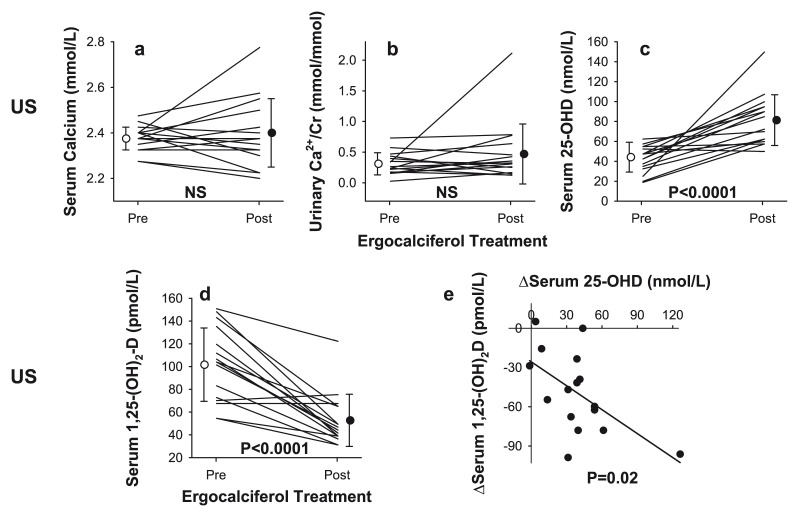
Serum and urine biochemical profiles in patients with sarcoidosis before and after vitamin D supplementation.Changes in (a) serum calcium, (b) urine calcium, (c) serum 25-hydroxyvitamin-D (25-(OH)D), and (d) serum 1,25-dihydroxyvitamin-D (1,25-(OH)2D) and (e) relationship between changes in serum 1,25-(OH)2D and 25-(OH)D before and after vitamin D repletion in 16 patients with active sarcoidosis and vitamin D deficiency. This figure was reproduced from Vitamin-D status and mineral metabolism in two ethnic populations with sarcoidosis, Capolongo et al., 64, 1025–34, 2020 with permission from BMJ Publishing Group Ltd12.